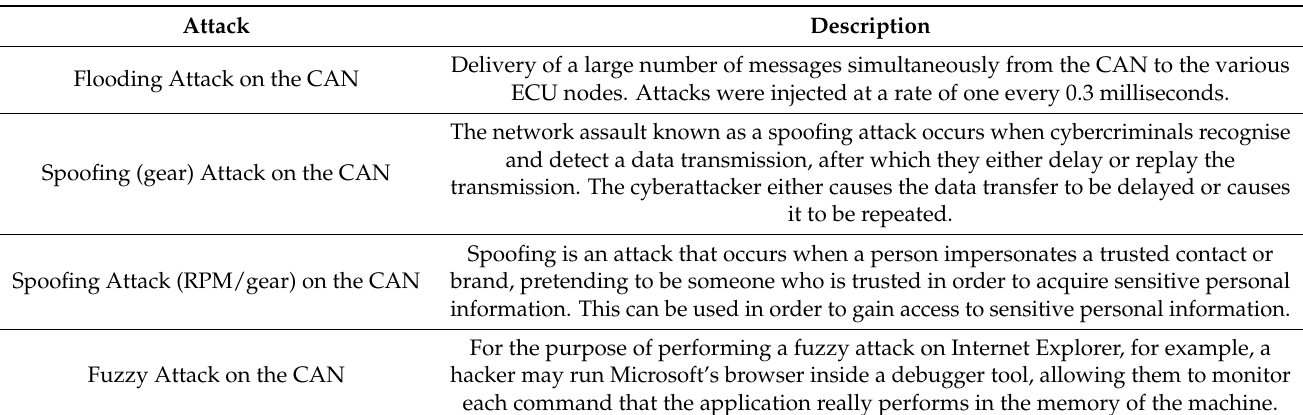
Table 2. CAN bus attacks.